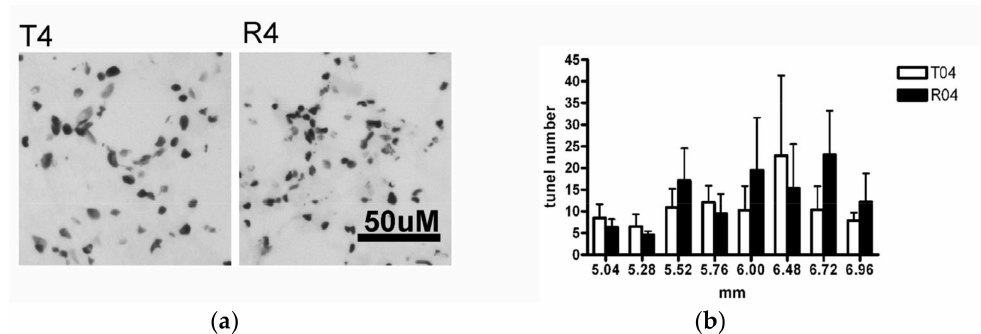
Figure 10. ( a ) The tunnel+ cells of the dorsal funiculus at 5.5 mm distance from the trauma center. This detects apoptotic cells in the dorsal funiculus, which were mostly oligodendrocytes. Animal number used: T4 ( n = 6) R4 ( n = 7). ( b ) At 4.8 mm to 6 mm from the trauma center, the number of tunnel+ cells was not different. Tested with pairwise t -test Animal number used: T4 ( n = 6) R4 ( n = 7). Scale bar = 50 µ m.